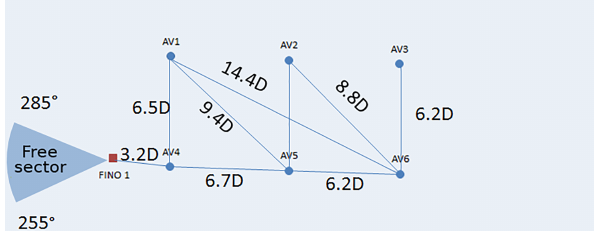
Figure 1. Schematic layout of the northern part of alpha ventus wind farm (circles) and FINO1 met mast (red square) with free-flow sector and distance in rotor